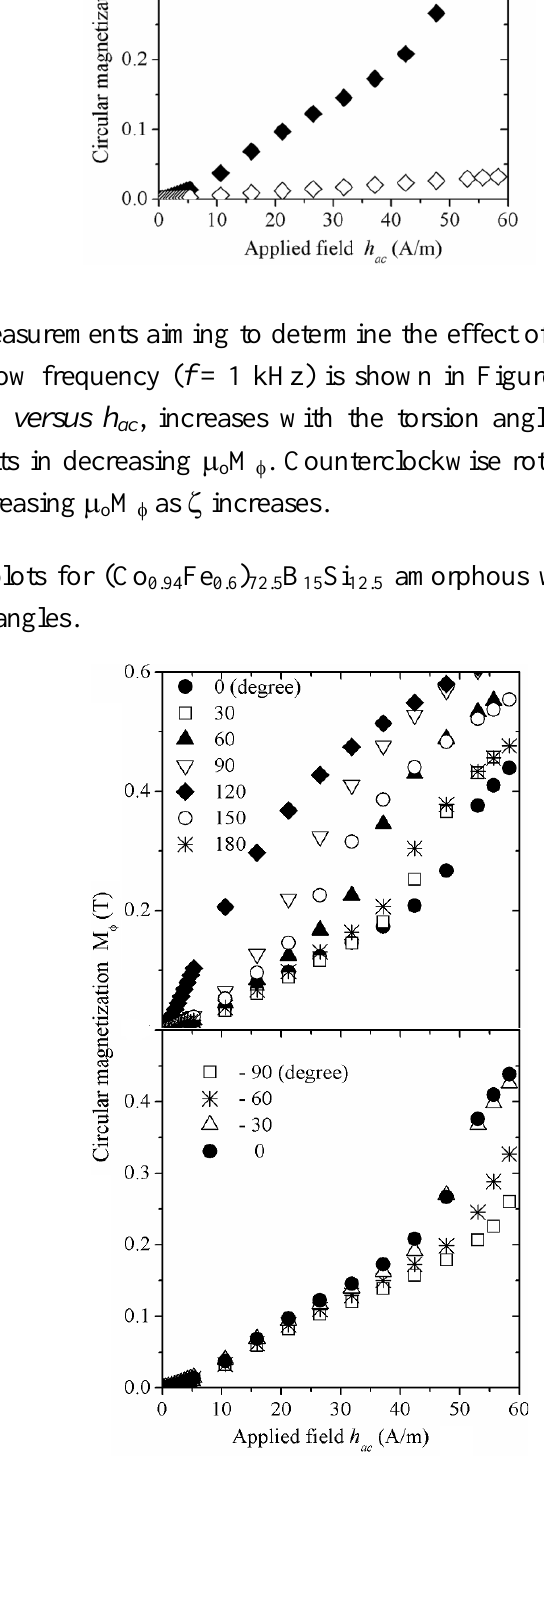
Figure 7. Circular magnetization plots M